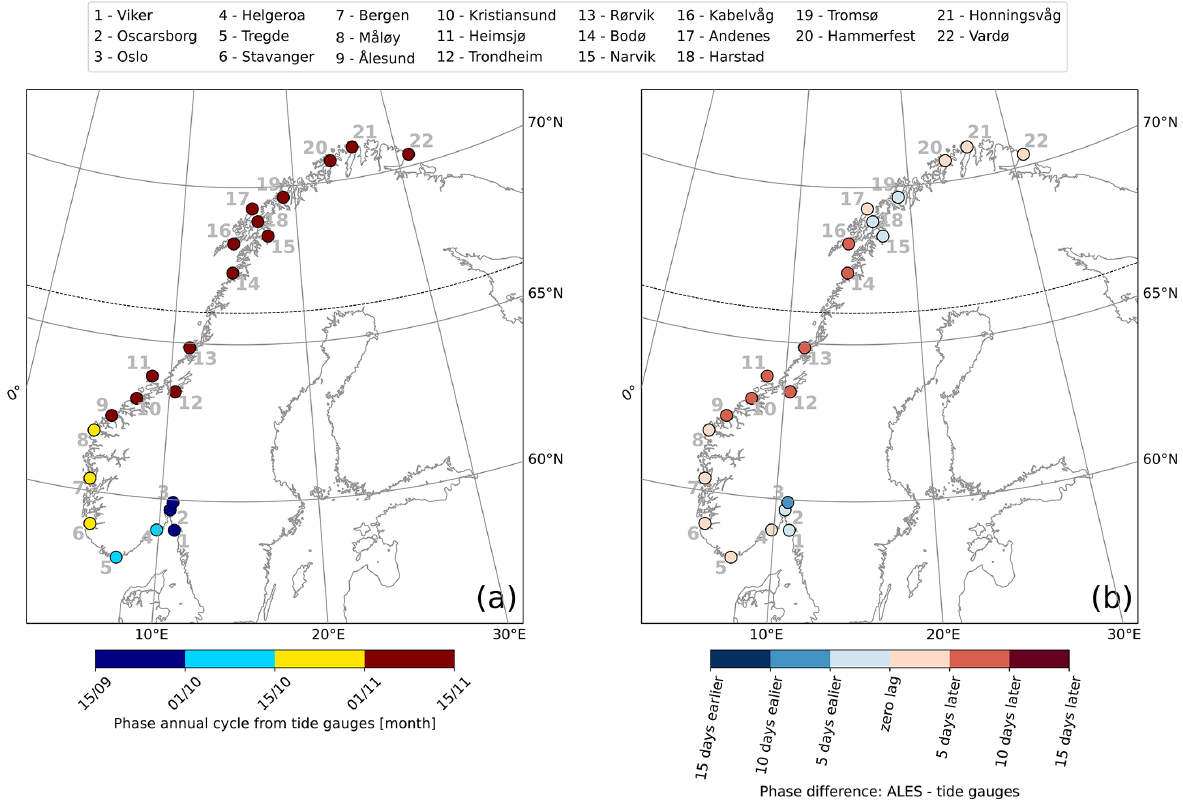
Figure 8. Comparison between the phase of coastal sea-level annual cycle from in situ measurements and area-averaged remote sensing data. At each tide-gauge location, the phase of the annual cycle from the tide gauges (a) and phase difference of the annual cycle from the ALES-reprocessed altimetry dataset and from the tide gauges (b) . The black dashed line indicates the 66 ◦ N parallel.